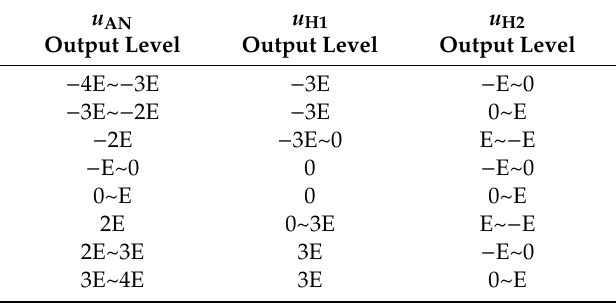
Table 3. The principle of